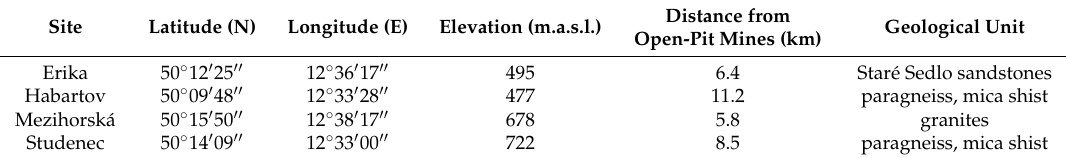
Table 1. Soil sample